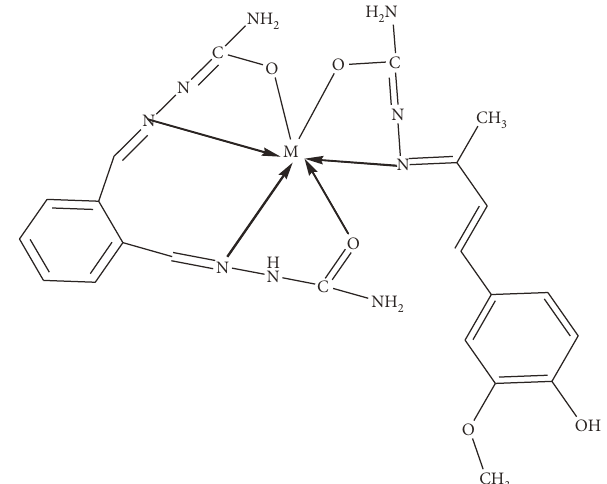
Figure 14: Proposed structures for [Cu( L